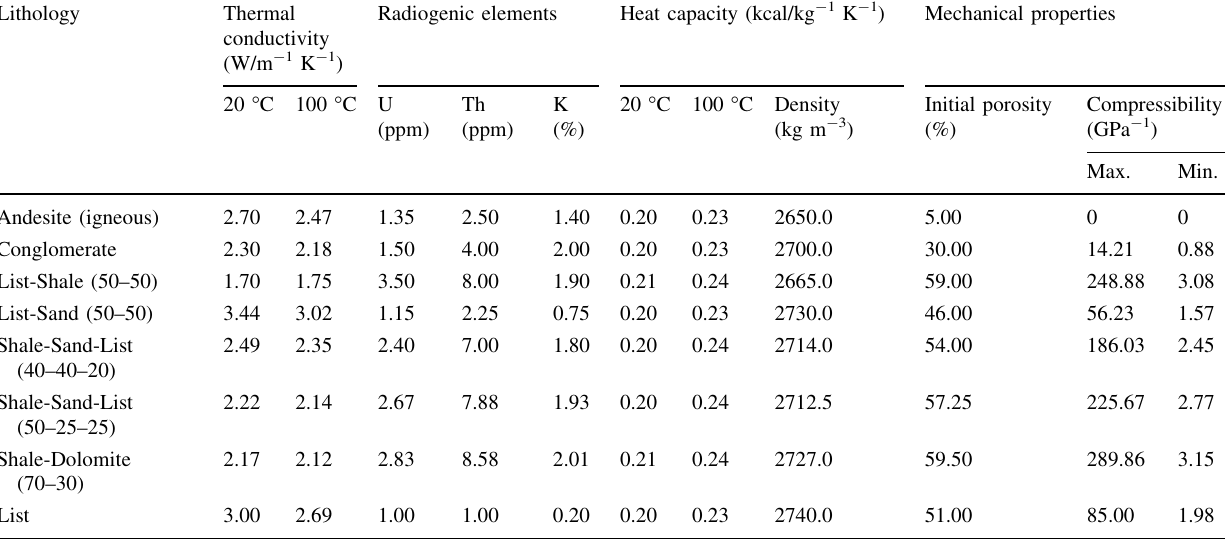
Table 3 Physical parameters of the sedimentary rocks used in modeling in the Parvadeh Area (PetroMod default parameters for these